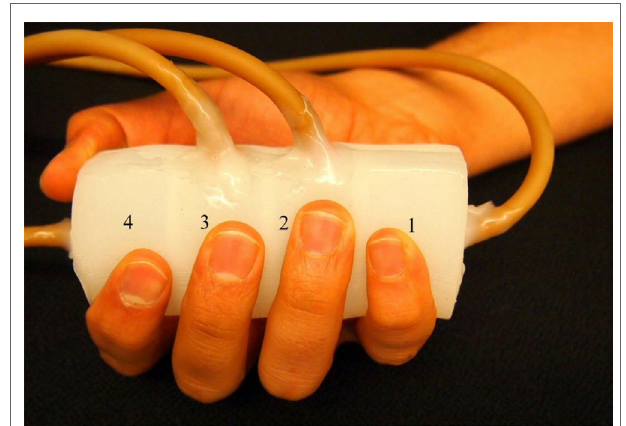
FigUre 1 | Finger sensor . The finger sensor consists of four chambers labeled as “1”–“4.” When holding the finger sensor, the thumb and index fingers are placed on chamber 4. The middle, ring, and little fingers are placed on chamber 3, 2, and 1,